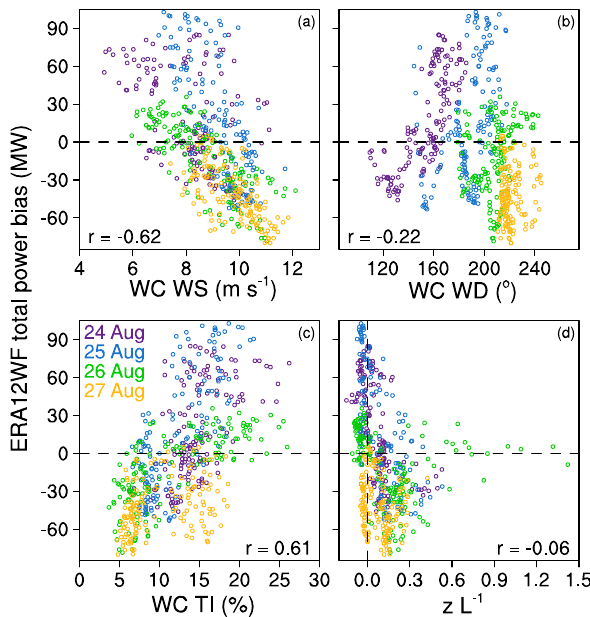
Figure 8. Scatter plots of the bias of the ERA12WF 10min to- tal power and the WC-observed hub-height WS (a) , hub-height WD (b) , hub-height TI (c) , and stability parameter zL − 1 measured at the surface flux station (d) . The r represents the Pearson correla- tion coefficient. Similar to Fig. 6, different coloured dots represent biases on different days. The horizontal black dash lines mark the zero power bias. In (d) , the vertical black dash line at zero zL − 1 differentiates the two stability